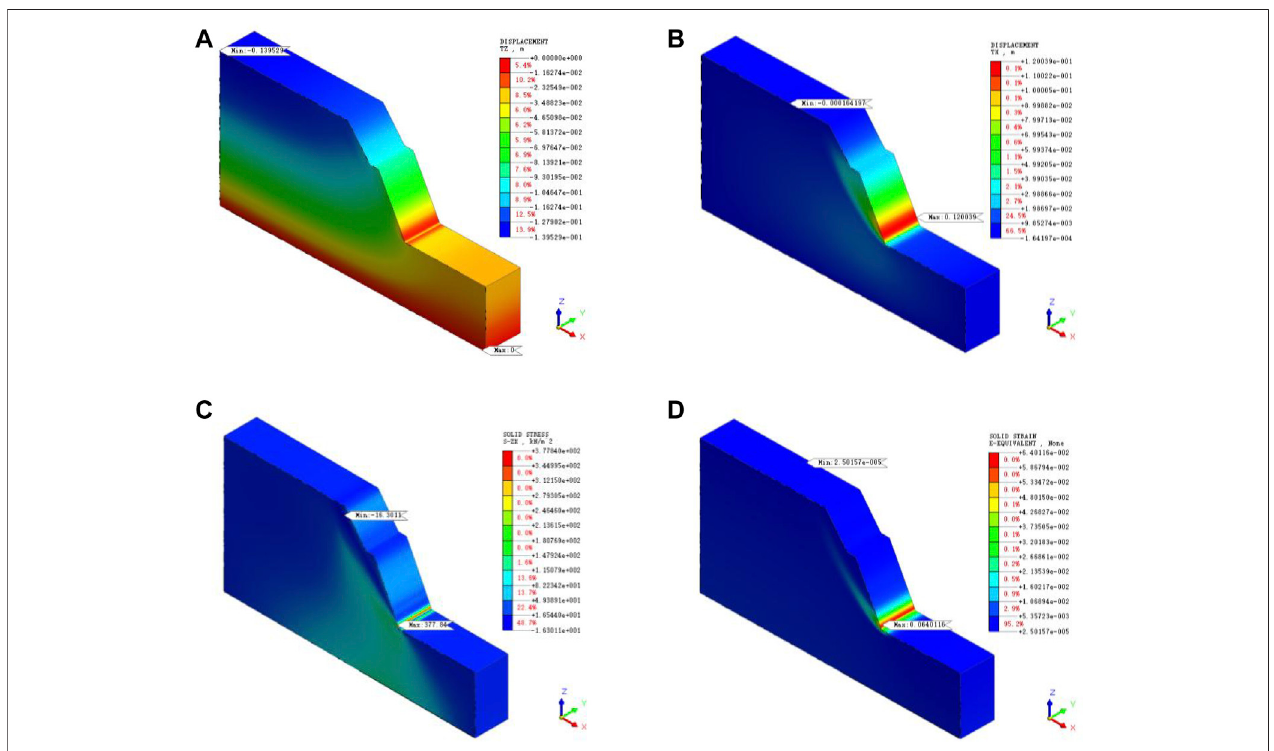
FIGURE 11 | Rock-slag slope model calculates results: (A) vertical displacement diagram of whole-rock slag; (B) horizontal displacement diagram of whole-rock slag; (C) XZ plane strain diagram of whole-rock slag; (D) plastic strain diagram of whole stone slag.